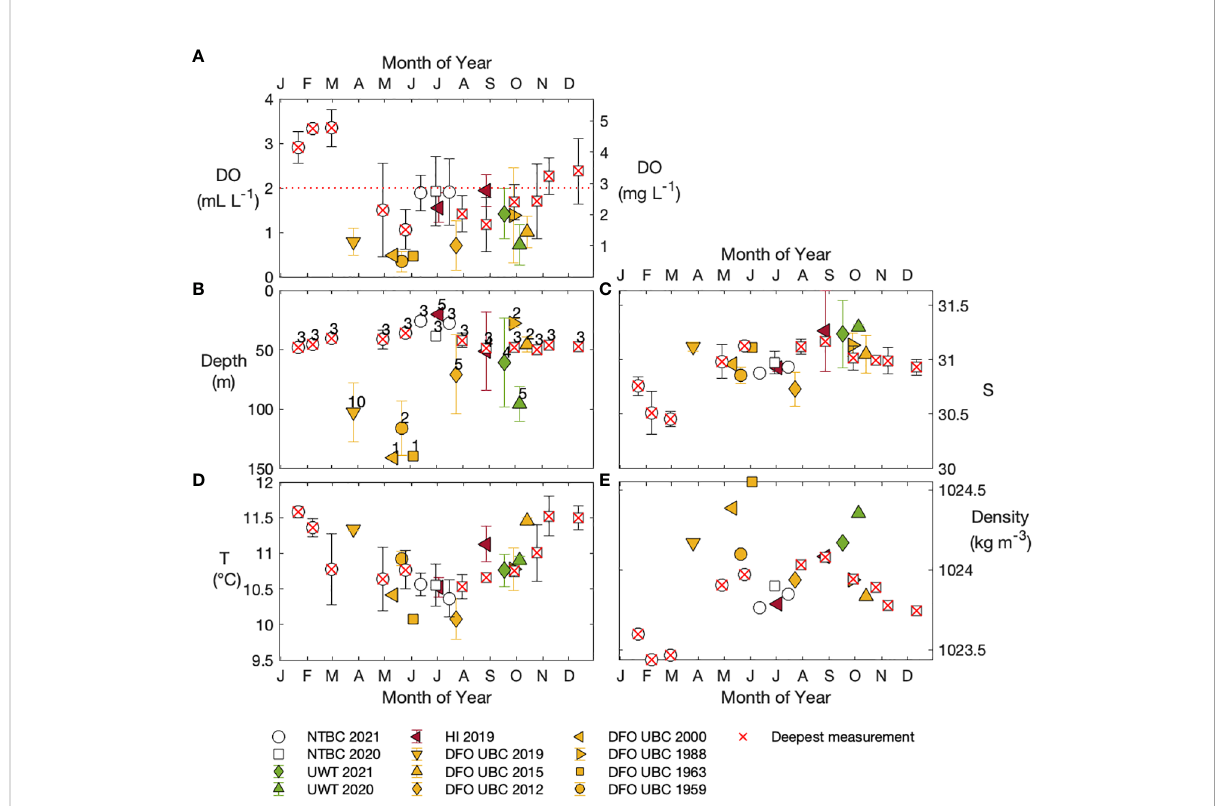
FIGURE 4 Seasonal comparison of NTBC data (Tables S4 – S6; open circles and squares) and historical properties: (A) oxygen concentration of Omin50 and Omin, (B) depth of Omin50 and Omin, and (C – E) . salinity, temperature, and density at Omin50 and Omin locations. Red crosses inside NTBC data markers denote months in which Omin50 was the deepest recorded measurement at one or more stations (data occupied top ~50 m only). Historical data span the full water column and are shown in yellow (Fisheries and Oceans Canada/University of British Columbia), red (Hakai Institute), and green (University of Washington - Tacoma); different shapes correspond to different sampling years. Omin and Omin50 properties in all datasets are spatially averaged (error bars show one standard deviation). Numbers above data points in panel (B) specify the number of stations for each legend